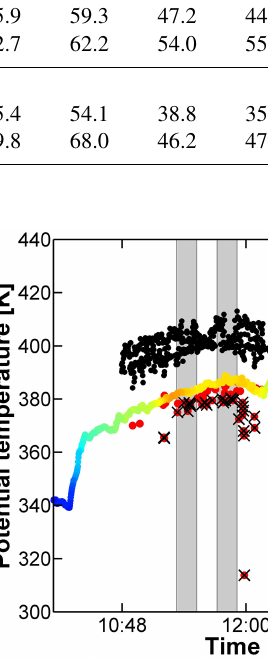
Figure 5. Solid line: time series of potential temperature (cid:50) mea- sured during the second half of TACTS flight 2 with PV as colour (from ECMWF data). Black dots: maximum potential temperature along 50-day back trajectories for all data points with (cid:50) > 370 and PV > 4pvu at the measurement location. Red dots further indicate the minimum potential temperature along the trajectories at flight sections where this minimum is below the measured values along the flight track. Red dots with PV > 7.5pvu and minimum (cid:50) at least 5K smaller than (cid:50) at the measurement are marked with a black cross (cf. Fig.